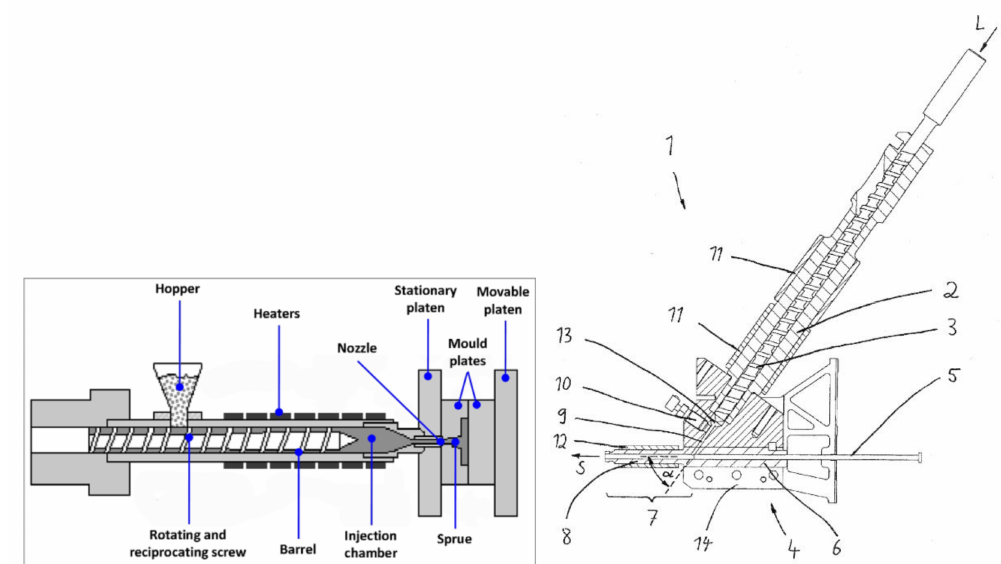
Figure 5. Elements of a conventional injection moulding machine ( left ). Reproduced with permission from [17]. Elements of the micro injection moulding machine considered in the present study ( right ): (1) plasticizing and injection unit, (2) screw cylinder, (3) plasticizing cylinder, (4) injection element, (5) injection piston, (6) injection cylinder, (7) metering section of the injection cylinder, (8) injection nozzle, (9) flow path, (10) pressure sensor, (11) heating element, (12) heating element, (13) volume, (14) distributor lock, (L) longitudinal axis, (S) injection cylinder axis, ( α ) angle between the screw and the injection cylinders.